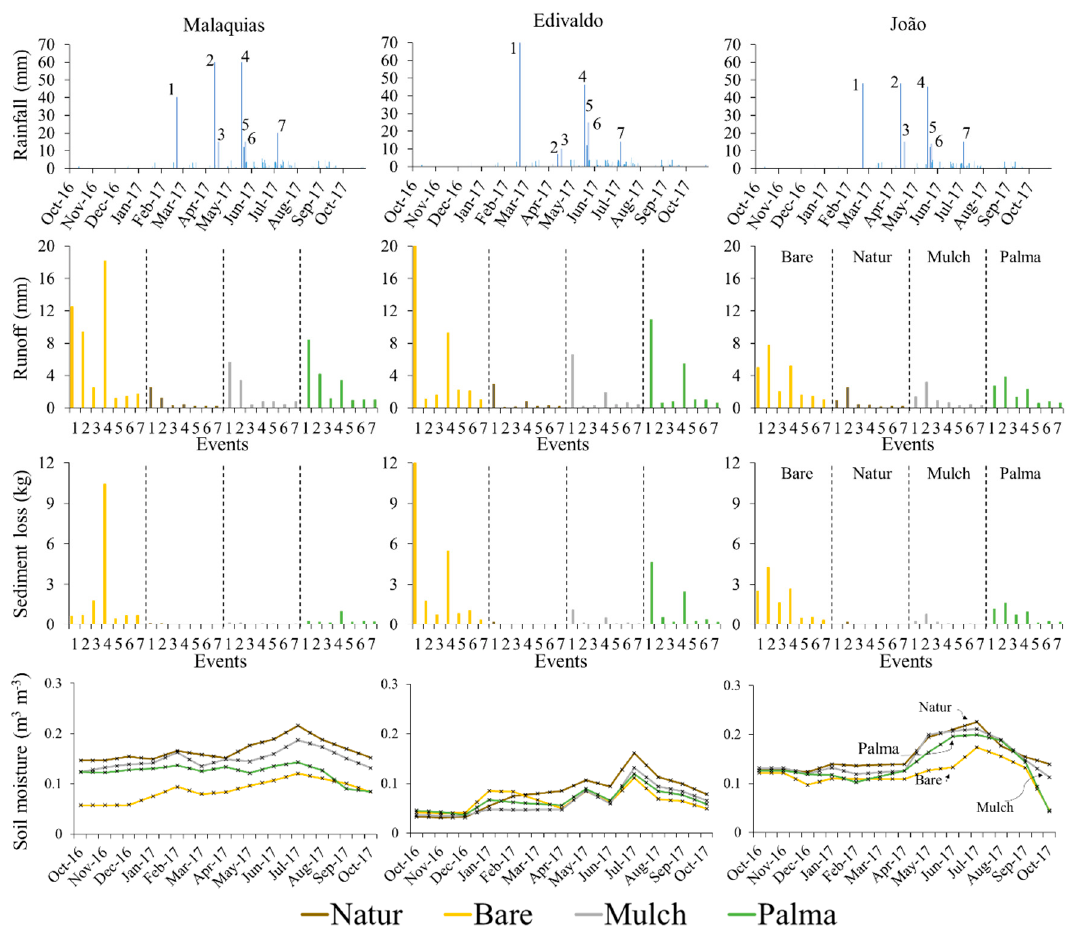
Figure 4. Time series of rainfall, runoff, sediment loss, and soil moisture during the study period. The cover condition identification was inserted in the charts of João, thus representing all the other sites.